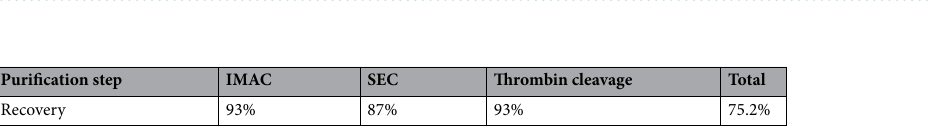
Figure 6. ESep and ESep* values calculated from the perfusion stability run (PSR) and perfusion run (P).